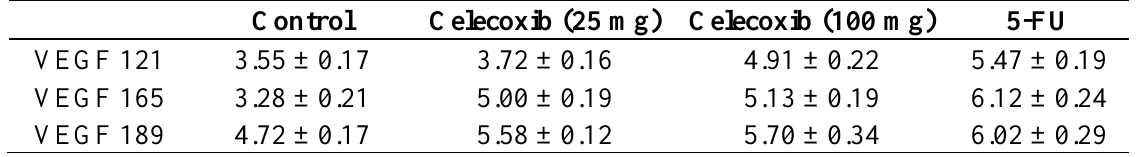
Table 1. The Δ CT of VEGF in four groups. Molecular isoforms of VEGF are generated by alternative splicing, rendering proteins containing 189-, 165- and 121-amino acid residues. VEGF 189, 165 and 121 were routinely detected in this series of ovarian